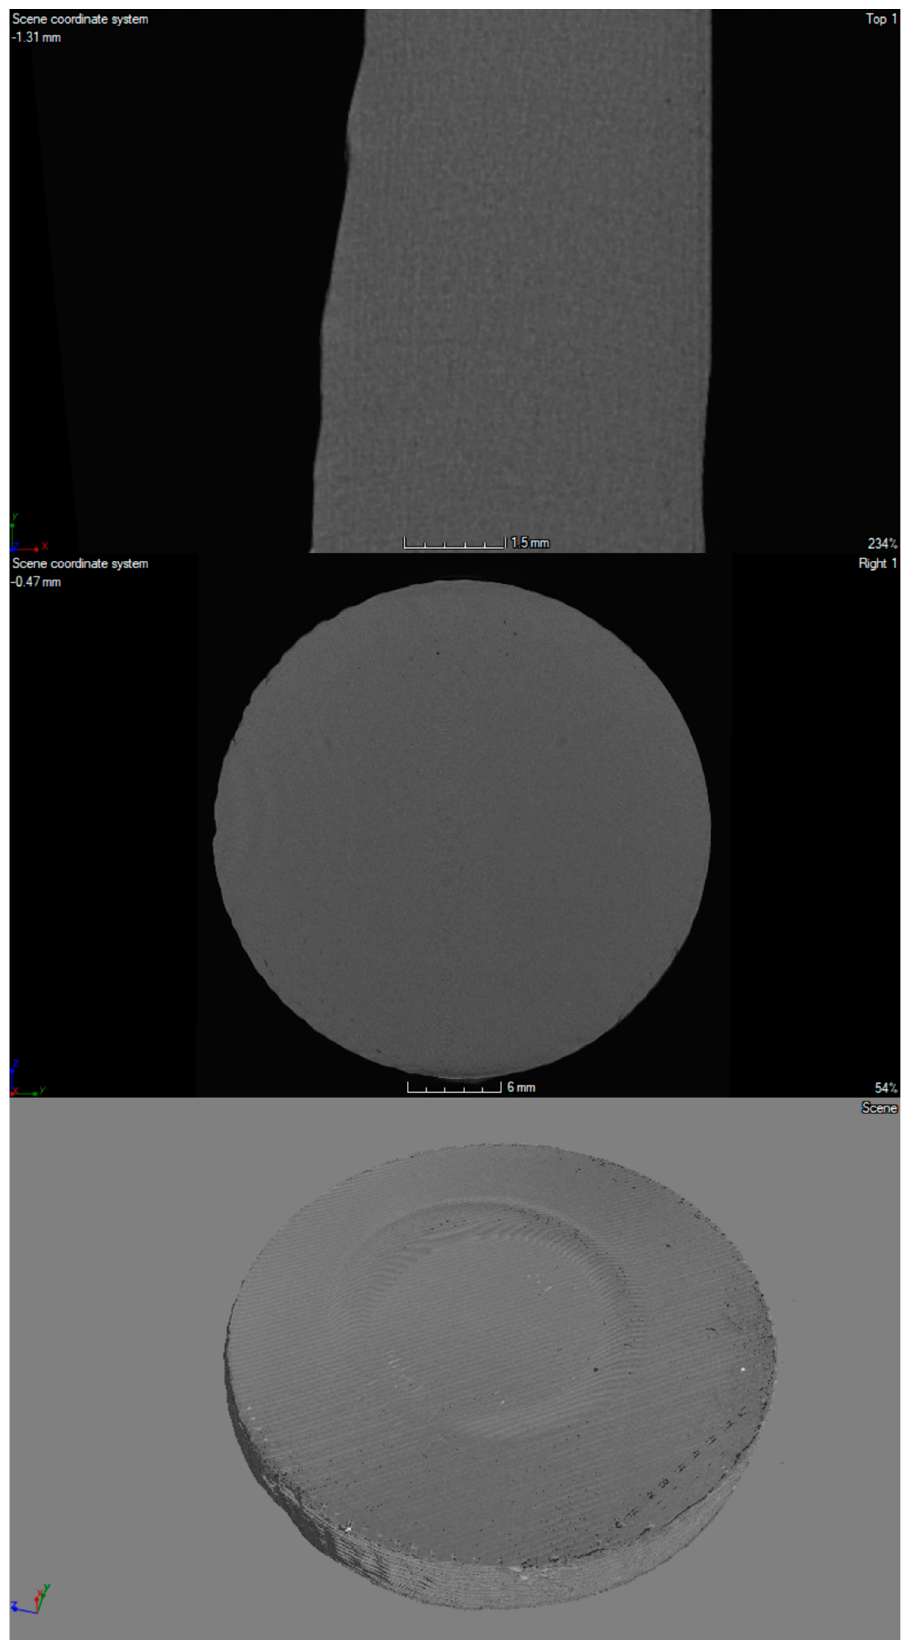
Figure 4. Micro CT imaging of 3D-printed porous standard plate modified with nanosilica .